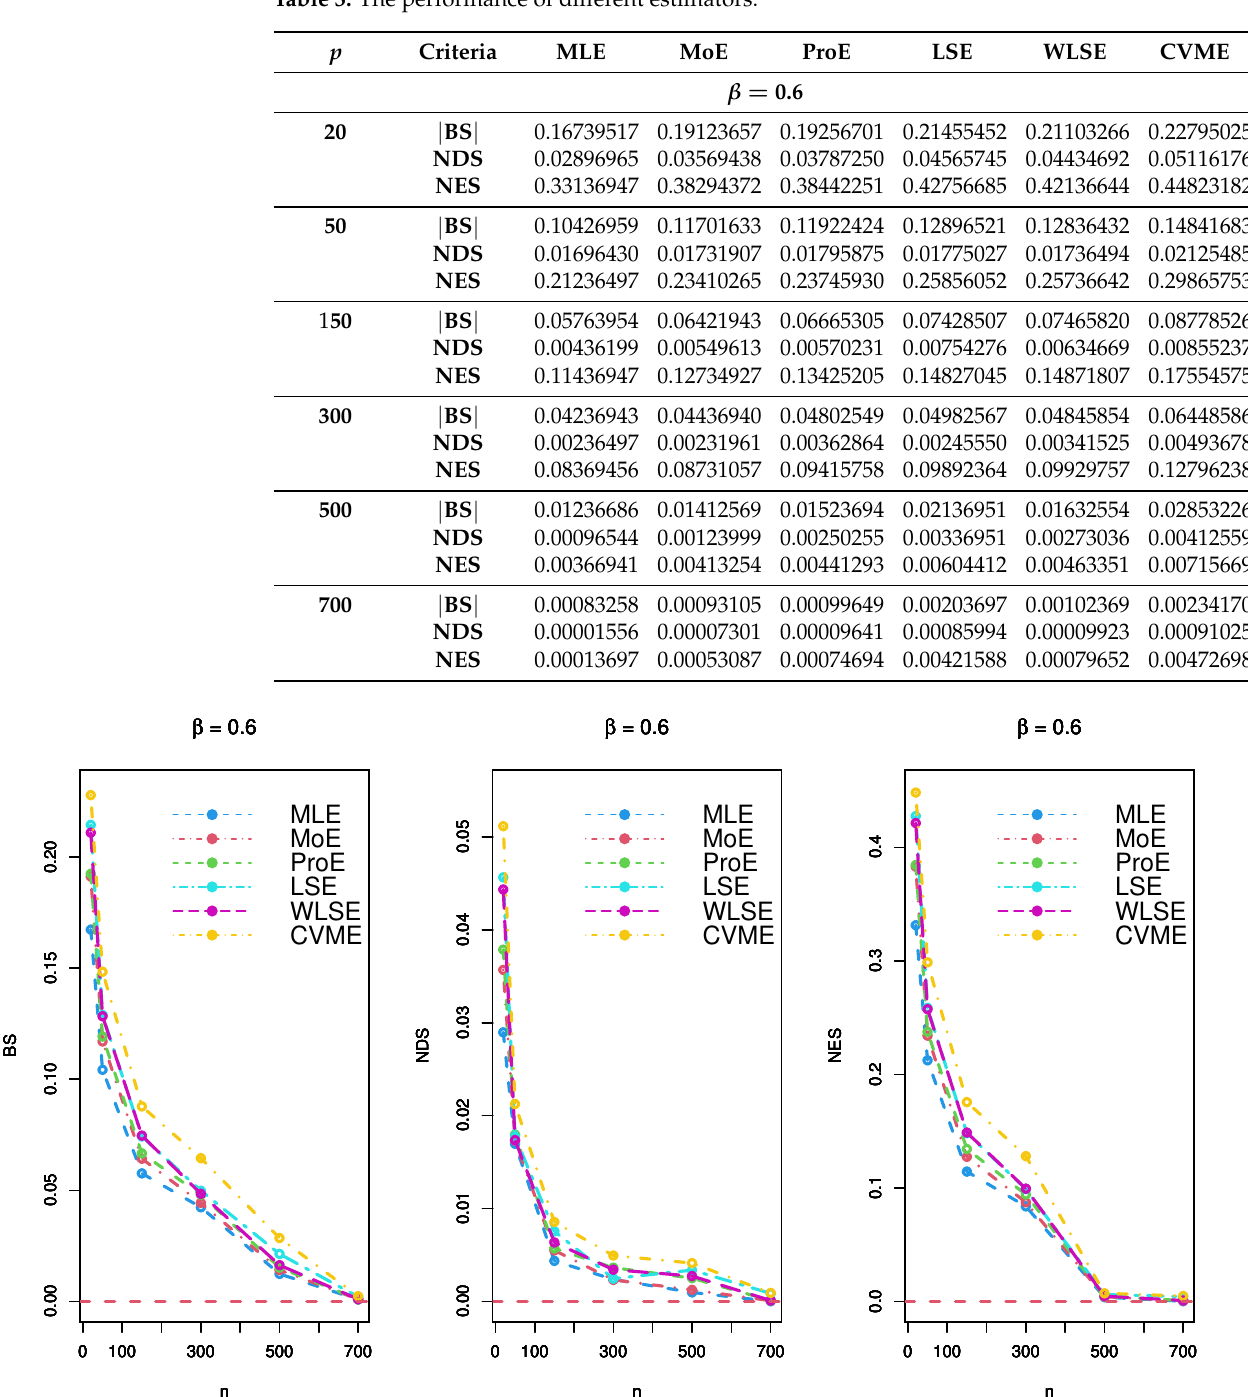
Figure 4. Simulation results for β = 0.6 under various estimation